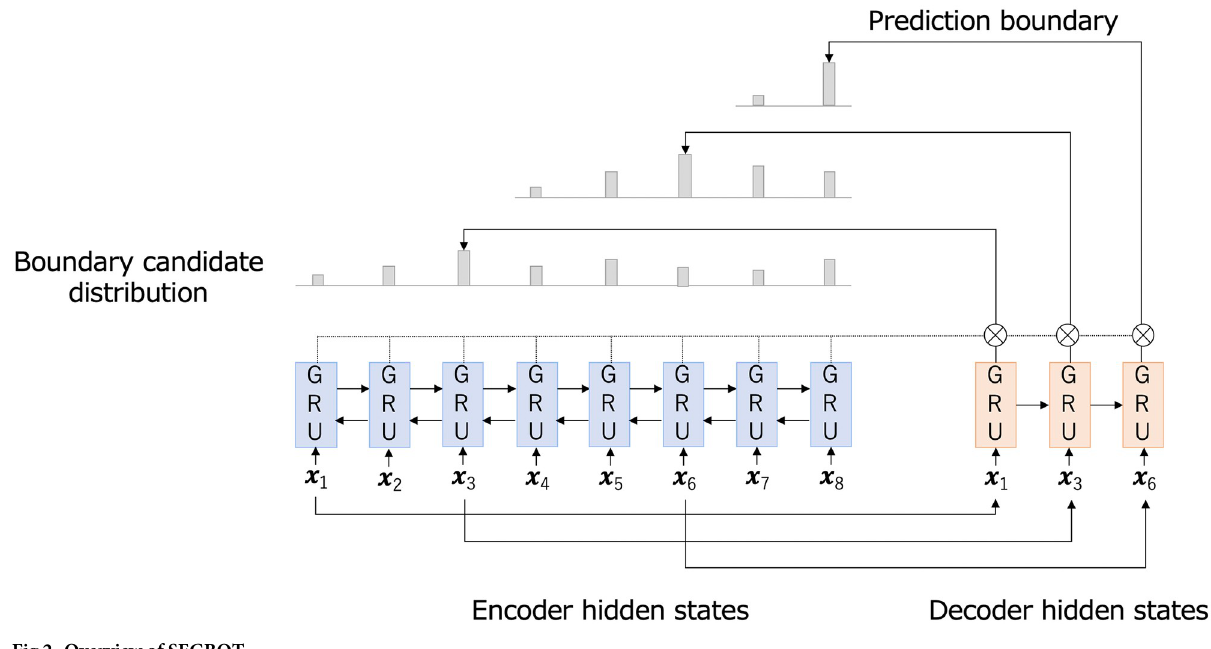
Fig 2. Overview of